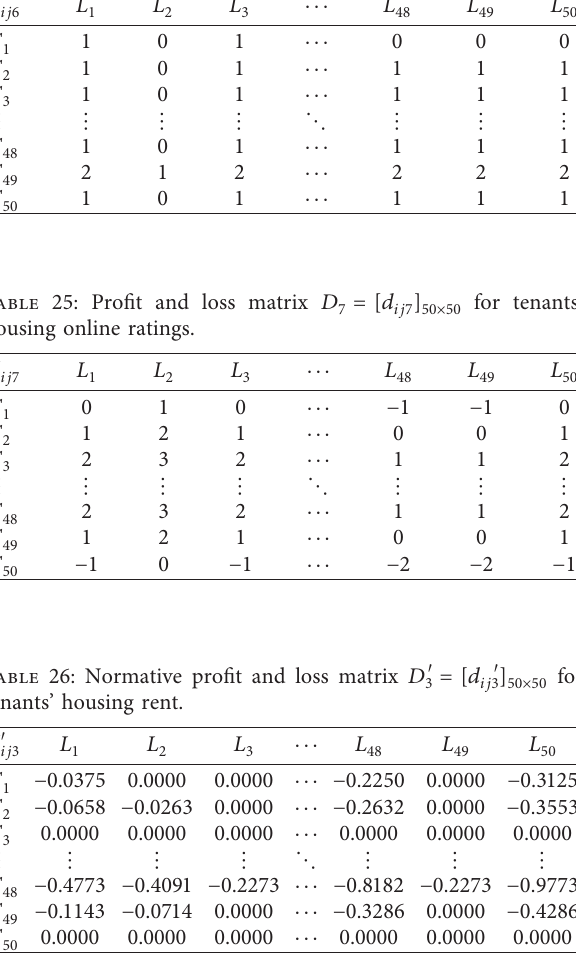
Table 24: Profit and loss matrix D housing decoration degree.